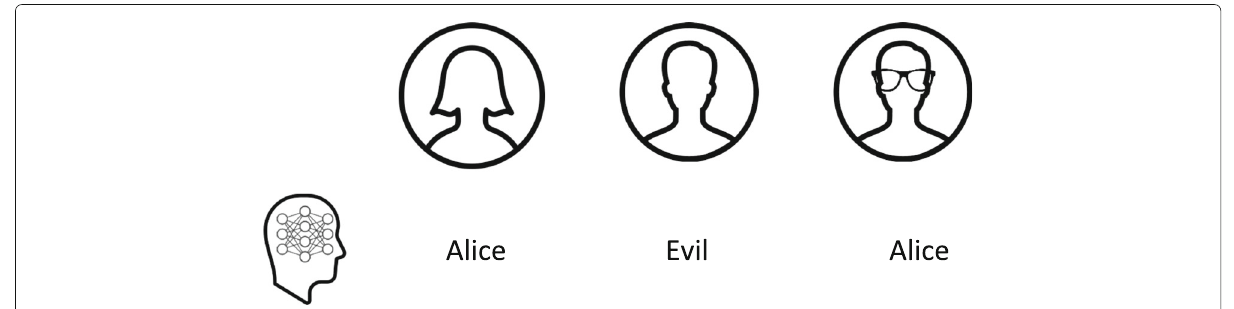
Fig. 5 Impersonation attacks with eyeglasses